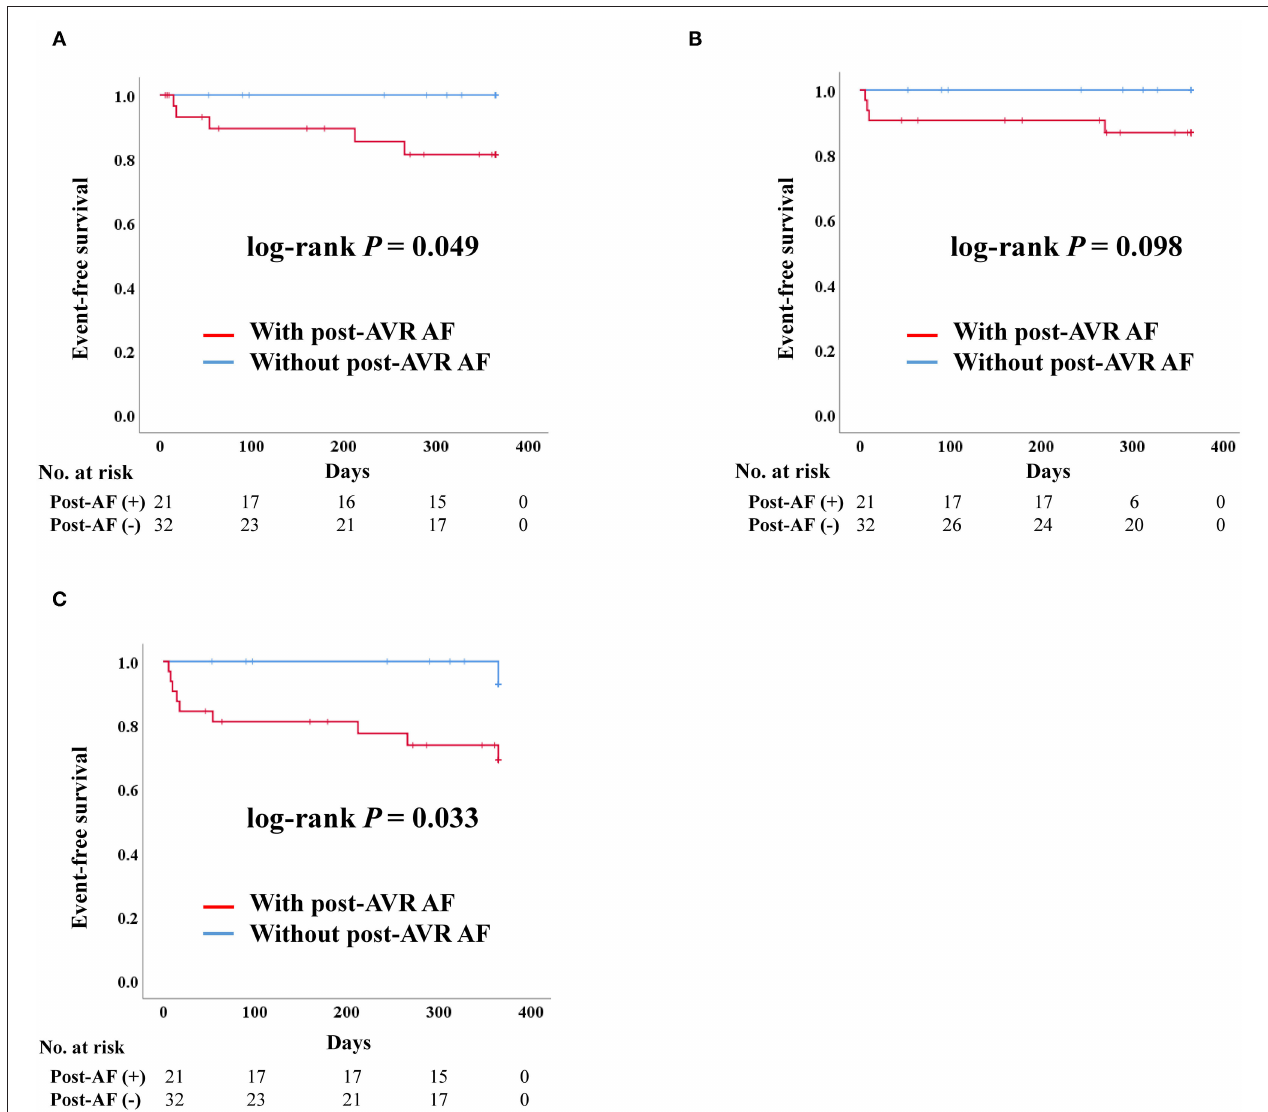
FIGURE 5 | Clinical outcomes of surgical aortic valve replacement (SAVR) according to post-SAVR atrial fibrillation after propensity score matching. Post-AVR AF, Post-surgical aortic replacement atrial fibrillation; Composite outcome, Composition of admission due to heart failure, stroke, or death. (A) Admission due to heart failure. (B) Death. (C) Composite